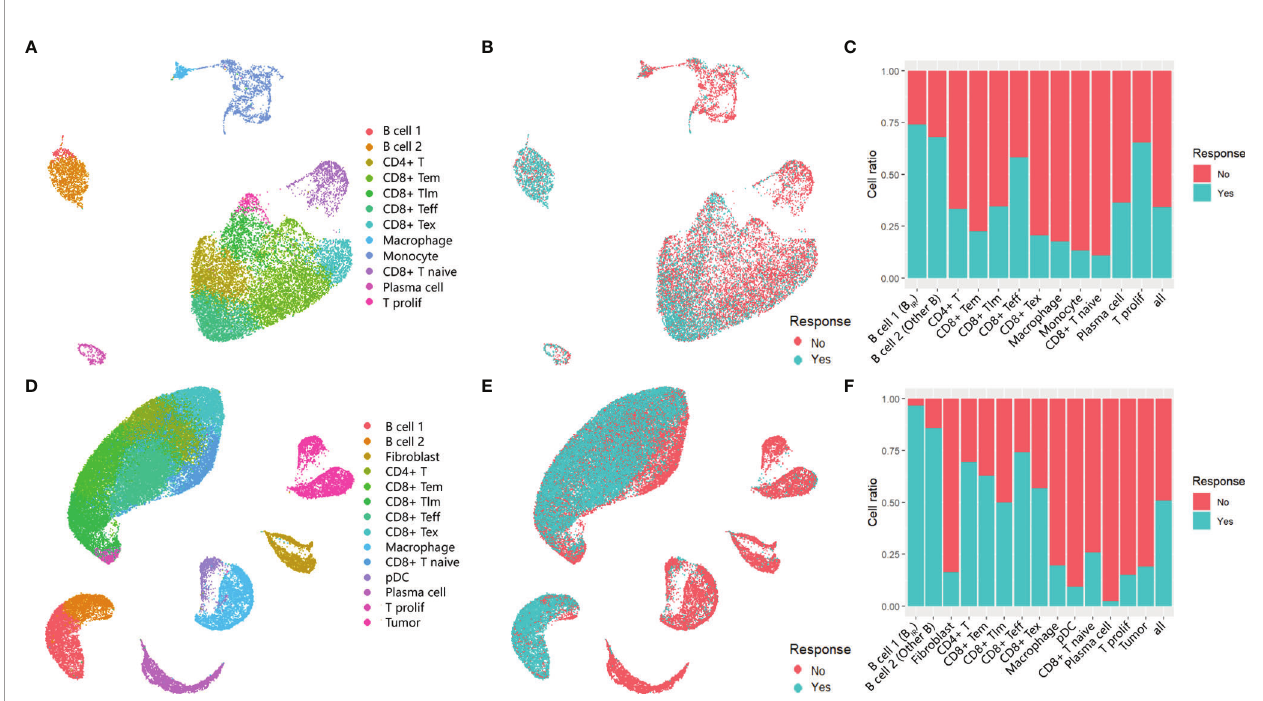
FIGURE 1 | Immune cells in the tumors of ICI responders. (A, B, D, E) UMAP plot of all cells in the tumors of patients treated with ICI,which visualize cell expression pro fi les in a two-dimensional. independent space. Data from two scRNA-seq datasets GSE120575 (A, B) and GSE123813 (D, E) were analyzed. Cells are colored based on clusters de fi ned by cell type (A, D) and patients' response to ICItherapy (B, E) . Tem, early memory T cells; Tim, late memory T cells;Teff, effector T cells;Tex, exhausted T cells;T prolif, proliferative T cells;pDC, plasmacytoid dendritic cells. (C, F) Histogram of the ratio of cell numbers from patients who respond to ICI therapy compared wi th all patients. Each cell type in pro fi les GSE120575 (C) and GSE123813 (F) are concerned.In the following text,'B cell1' is named as 'ICI-Responsive B cells (B IR )' because of its highest cell ratio in tumor tissue of patients with favorable response to ICI therapy. Correspondingly, 'B cell 2' is called 'other B